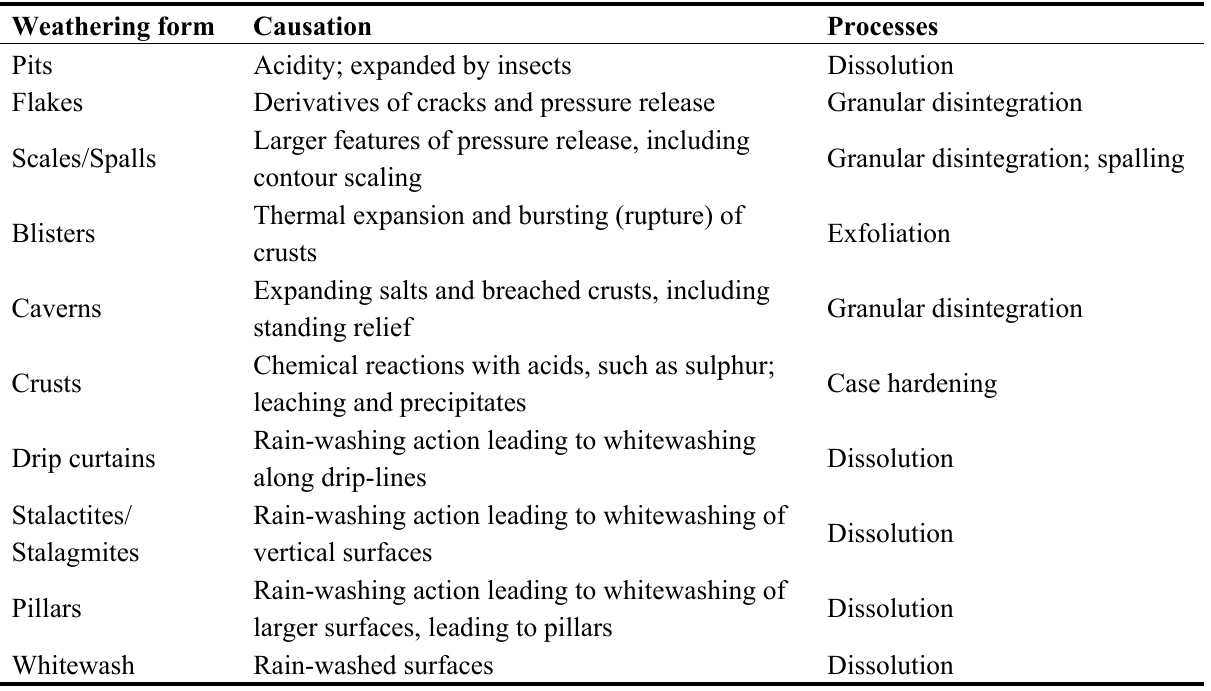
Table 2. Causation typical of a selection of weathering